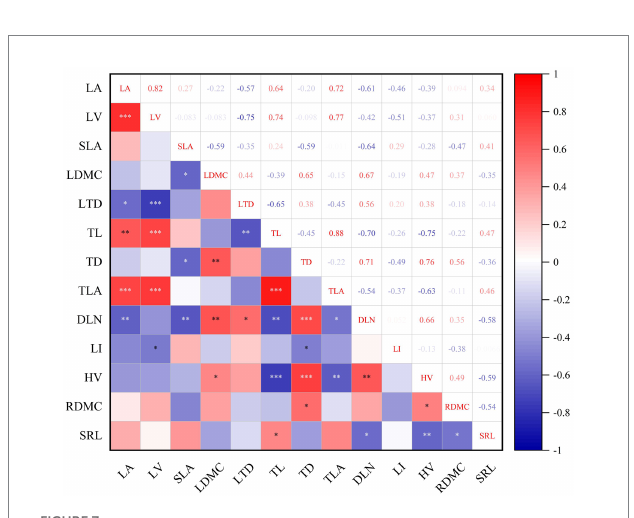
FIGURE 7 Correlation analysis of functional traits in different organs of Abies georgei var. smithii. in southeast Tibet (Pearson). * p <= 0.05; ** p <= 0.01; *** p < =